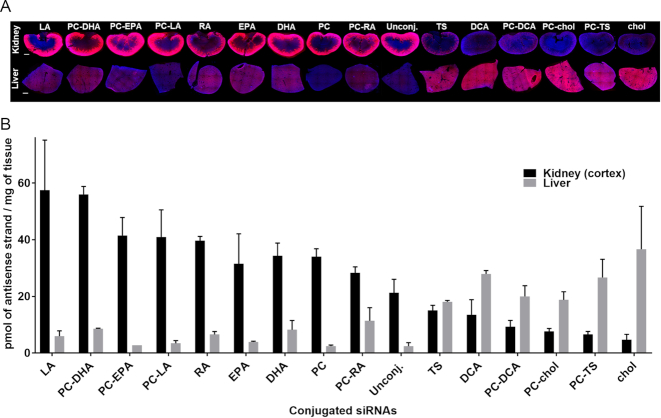
The conjugate defines the ratio of liver to kidney distribution. (A) Representative fluorescence images of kidney and liver sections from mice injected subcutaneously with 20 mg/kg Cy3-labeled lipid-conjugated siRNAs. Nuclei stained with DAPI. Three mice per conjugate were injected and tissue collected 48 h after injection. Images taken at 5 × magnification and collected at the same laser intensity and acquisition time. Scale, 1 mm. (B) siRNA quantification in kidney (cortex) and liver was performed by PNA hybridization assay (average of three mice per conjugate ± SD).